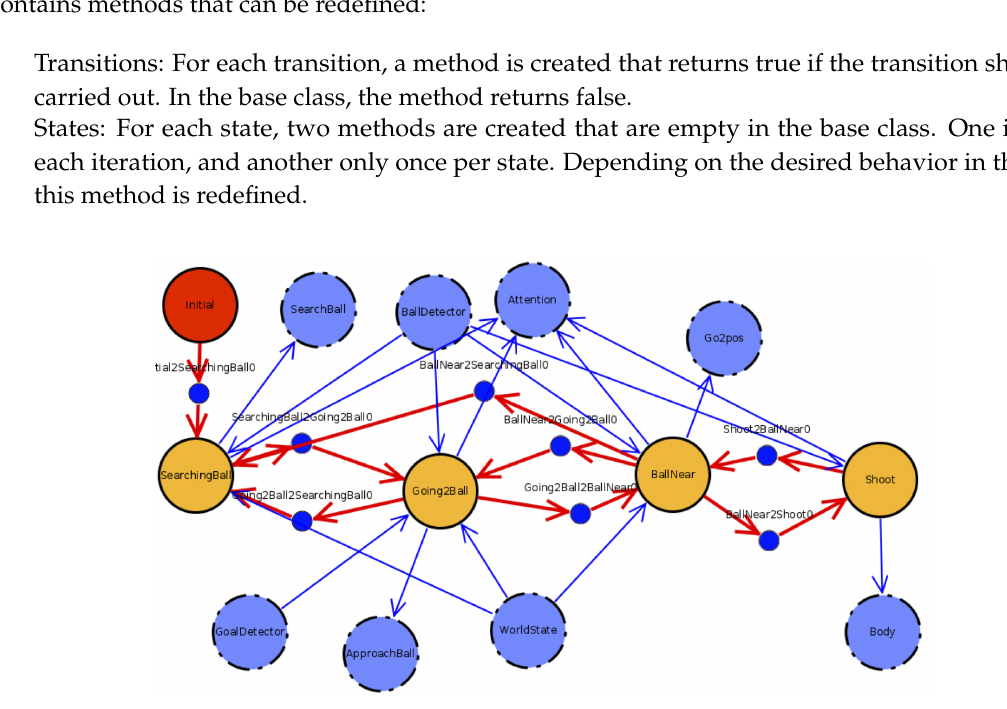
Figure 8. Finite state machines with component dependencies per